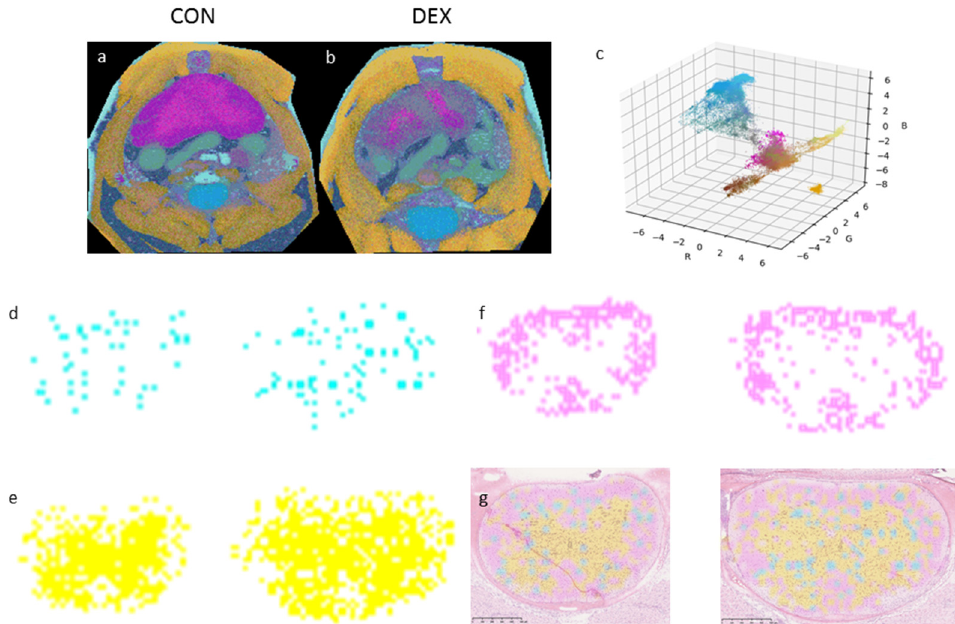
Figure 6. UMAP analysis from tMSI data. ( a ) Segmentation images based on UMAP analysis were shown ( a , b ). Each segment calculated by UMAP was visualized in a three-dimensional space with graph layout algorithms ( c ). Color used in ( c ) is identical to ( a , b ). ( a ) control mouse, ( b ) DEX-treated mouse, ( d – g ) UMAP-profiled metabolic status of the spinal cord. Three metabolomic clusters were marked with blue ( d ), yellow ( e ), and pink ( f ). Yellow color is consistent with grey matter and pink color is consistent with white matter. Blue color looks like nucleus of various interneurons included in grey matter. Three colored images were merged on the HE staining of the spinal cord shown in ( g ).